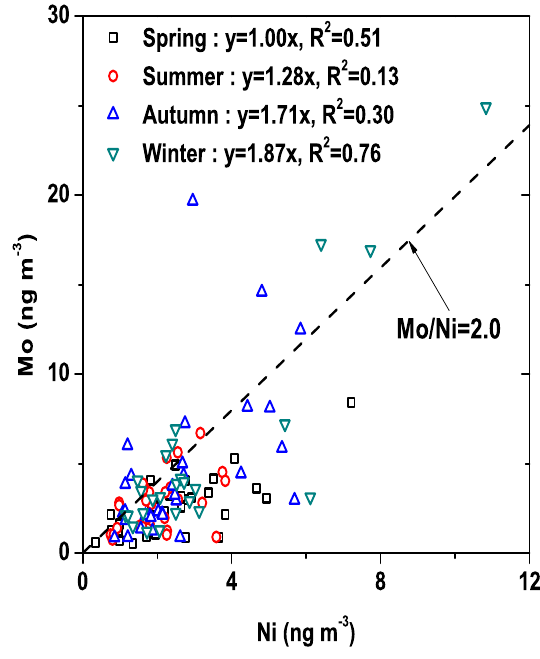
Figure 9. Scatter plots of Mo and Ni in four